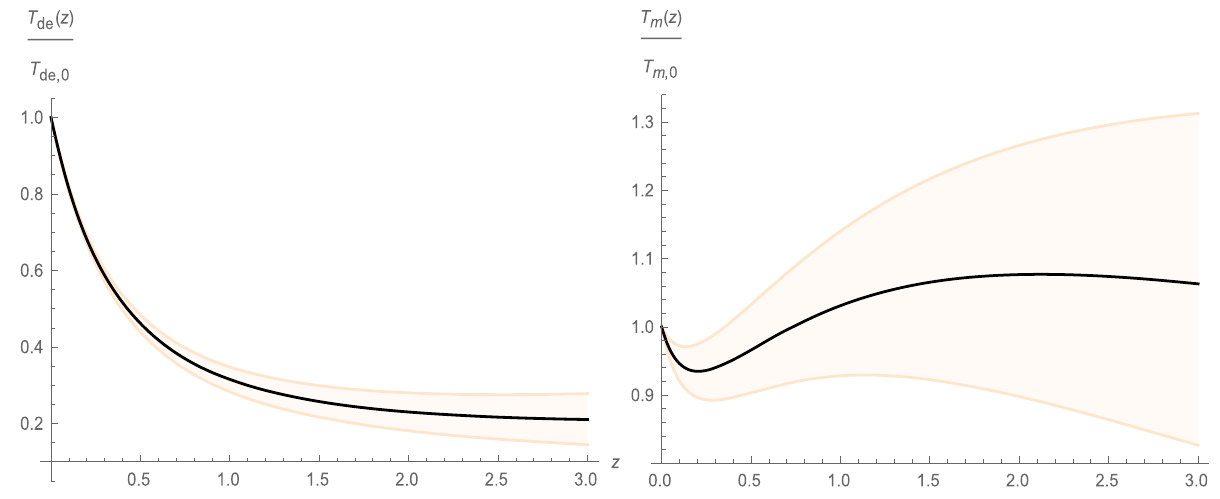
Fig. 6 Temperatures of the dark sector. The black solid line corresponds to the best fit values ω 0 and ω a in both panels, the shaded regions correspond to the errors propagation